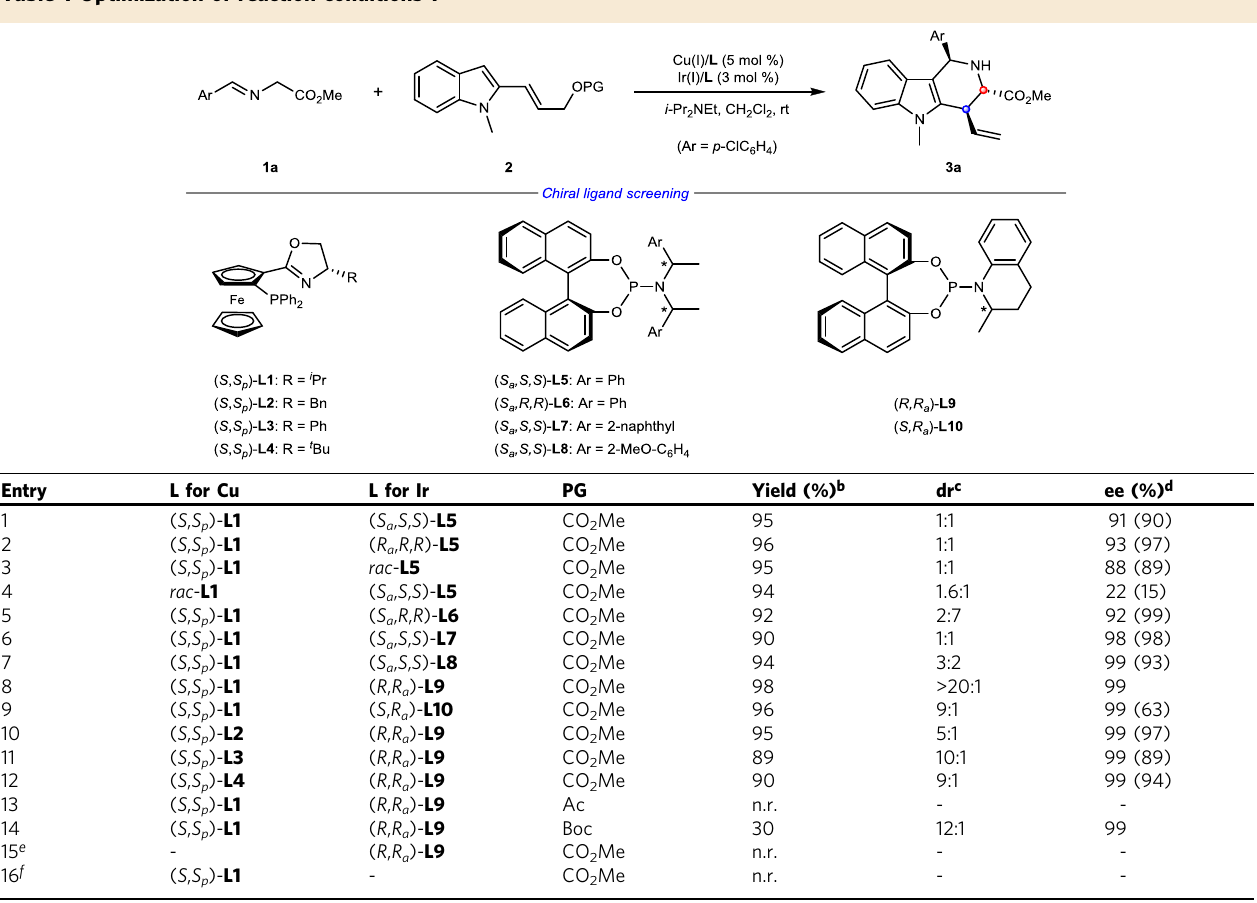
Table 1 Optimization of reaction conditions a